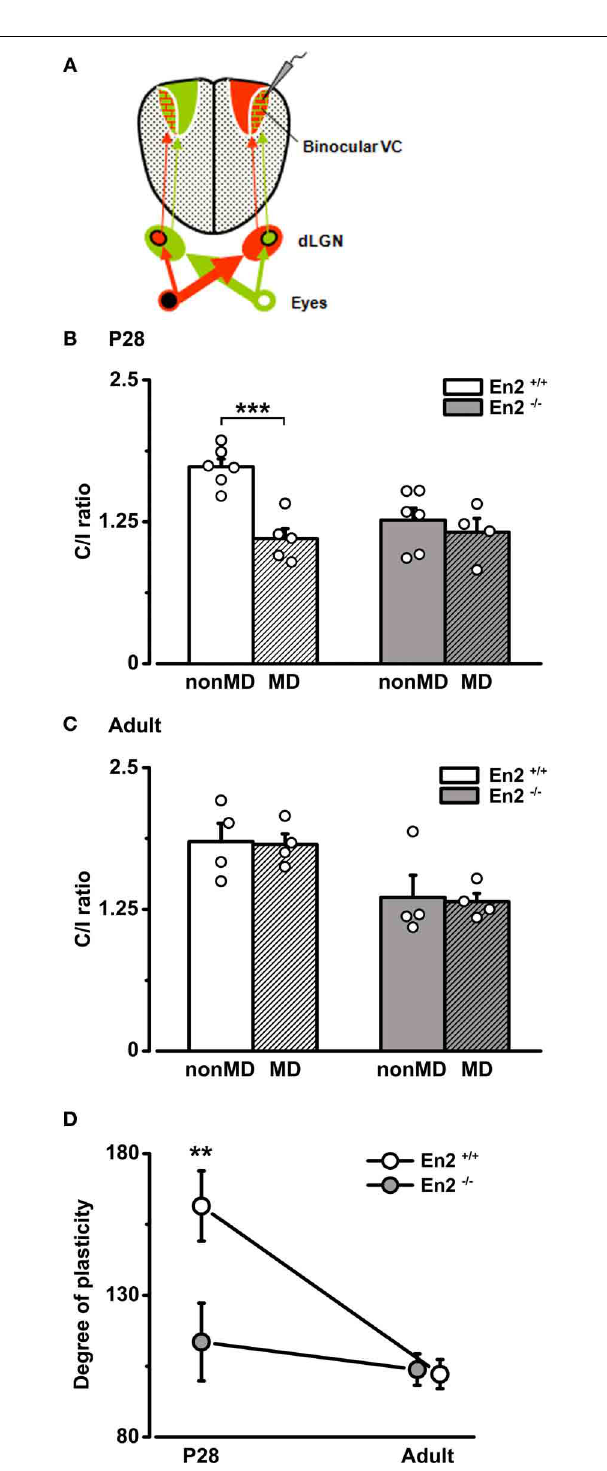
FIGURE 7 | Absence of OD plasticity in En2 − / − mice. (A) Schematics of the experimental protocol for VEP recordings performed contralateral to the deprived eye. (B,C) C/I VEP ratios in En2 + / + (white) and En2 − / − (gray) mice either non-deprived (non-MD) or monocularly deprived for 3 days (MD; shaded columns). (B) Juvenile animals. Note the significant decrease in